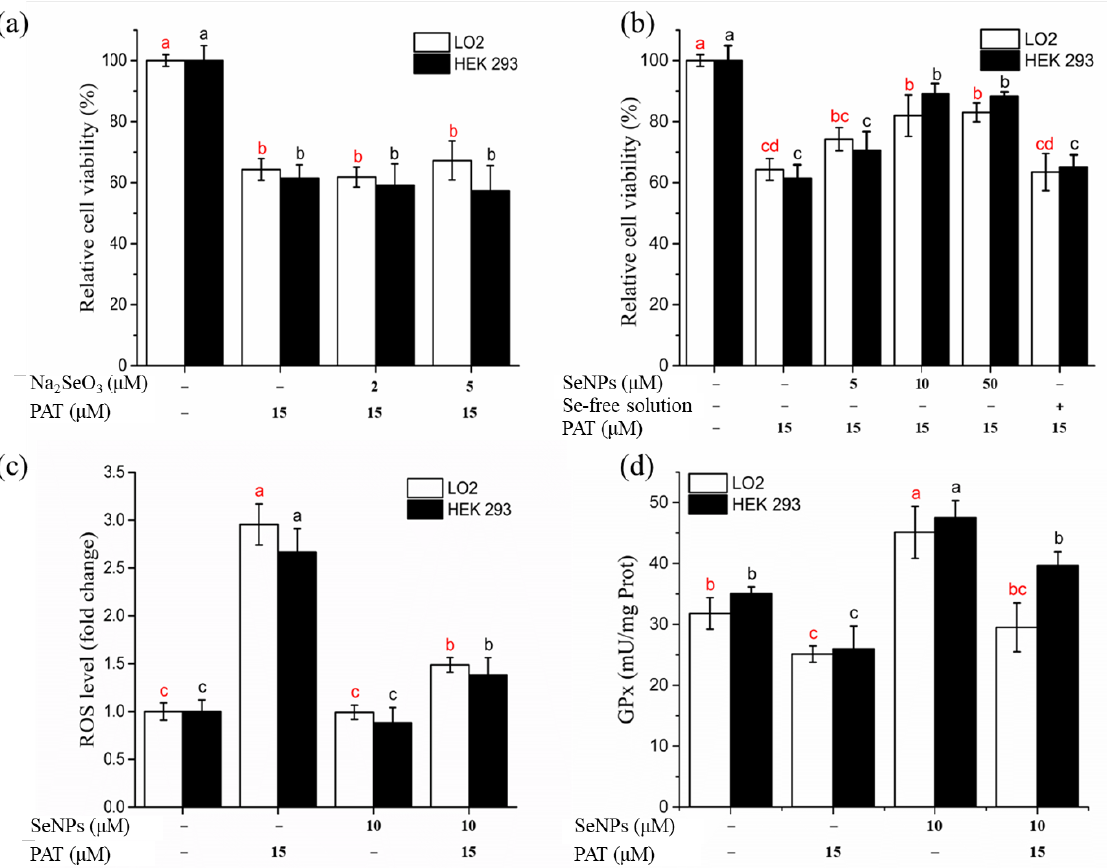
Figure 4. Effects of SeNPs on PAT-induced cytotoxicity in LO2 cells and HEK 293 cells. ( a ) Effect of Na 2 SeO 3 on PAT-induced growth inhibitory of LO2 cells and HEK 293 cells. ( b ) Effect of SeNPs on PAT-induced growth inhibitory of LO2 cells and HEK 293 cells. ( c ) Effect of SeNPs on PAT-induced overproduction of ROS. ( d ) Effect of SeNPs on PAT-induced inhibition of intracellular GPx activity. The results are expressed as means ± SD. The different lowercase letters in the same color indicate significance ( p < 0.05) of values.